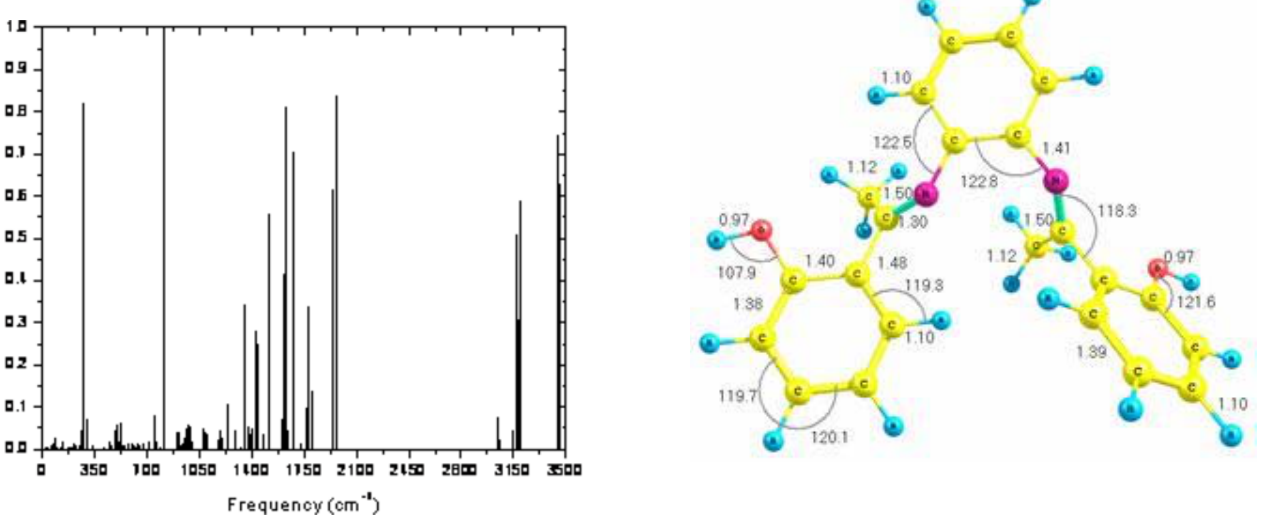
Figure 1. AM1 optimized structure and its theoretical IR vibrational spectrum for molecule 3